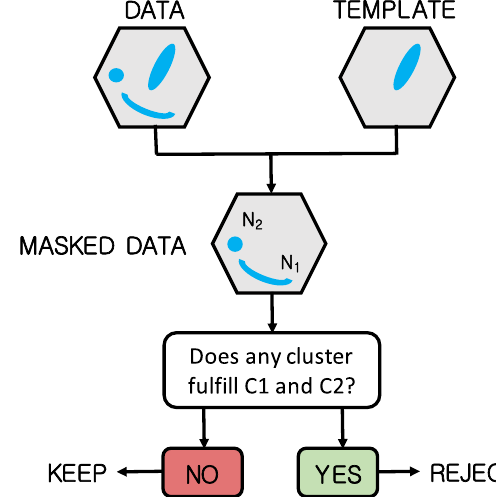
Fig. 2 Schematic diagram representing the algorithm structure